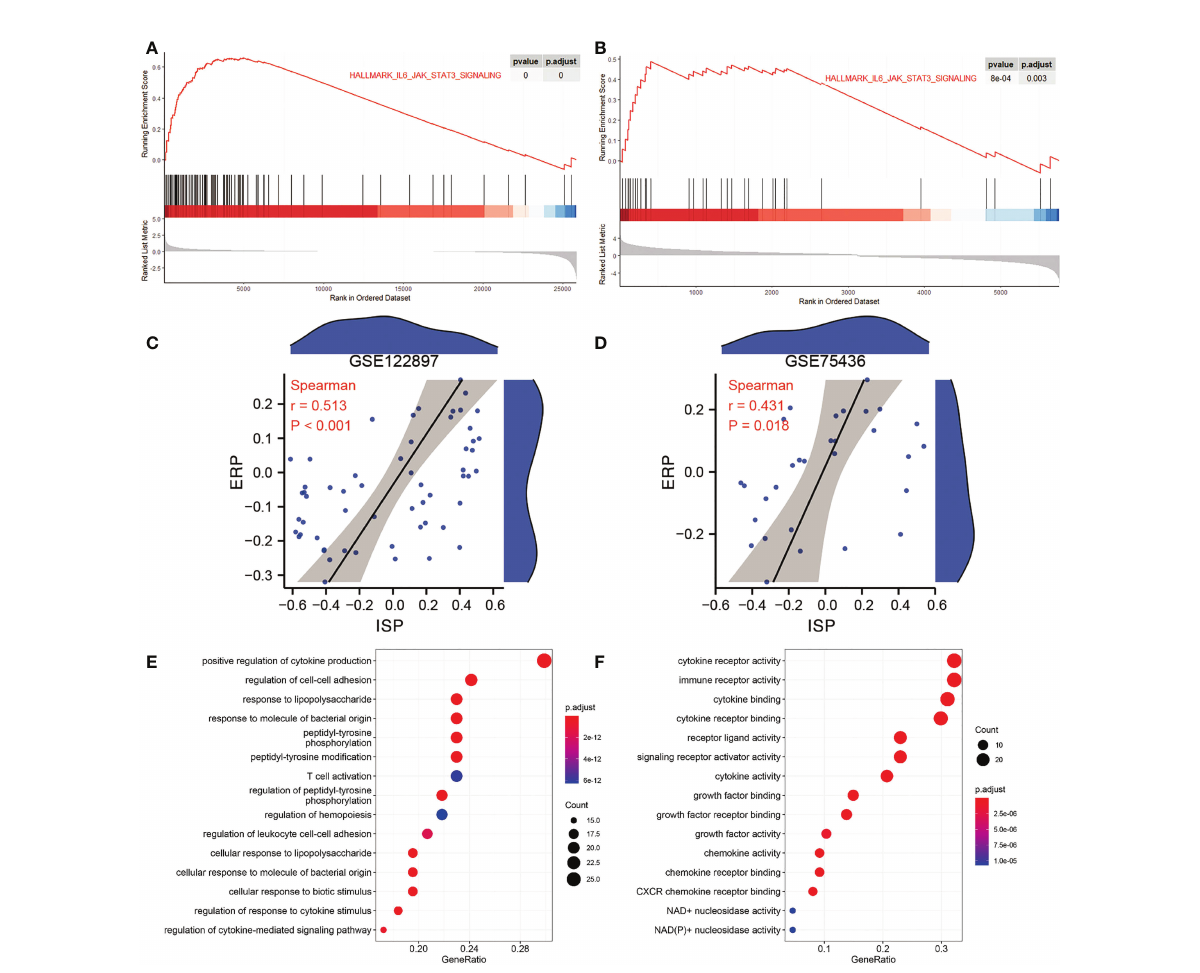
FIGURE 2 Functional Correlation Analysis of the IL6/JAK/STAT signaling pathway (ISP) (A) The Gene set enrichment analysis (GSEA) result of the ISP in GSE122897. (B) The GSEA result of the ISP in GSE75436. (C) The correlation of the ISP and the estrogen response pathway (ERP) in GSE122897. (D) The correlation of the ISP and ERP in GSE75436. (E) Gene Ontology (GO) Biological Process (BP) enrichment analysis. (F) GO Molecular function (MF) enrichment